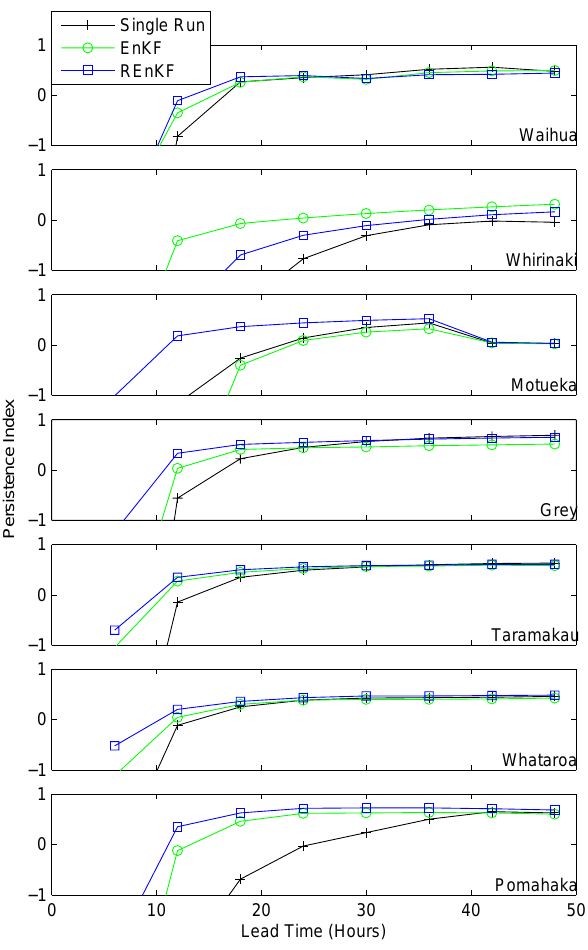
Fig. 9. Persistence index scores by catchment for single model run (no assimilation), EnKF and REnKF, for lead times 6–48h, calcu- lated for time period 1 April 2011–31 March 2012. Graphs are trun- cated at a score of − 1 to improve